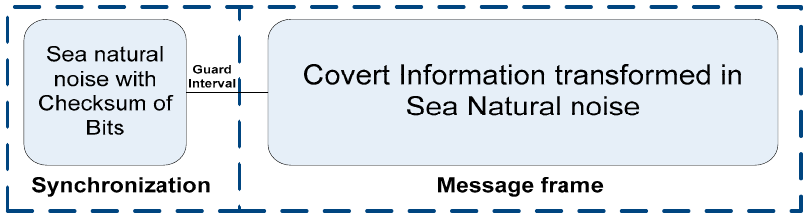
Figure 6. Frame structure of bionic mimicry communication.